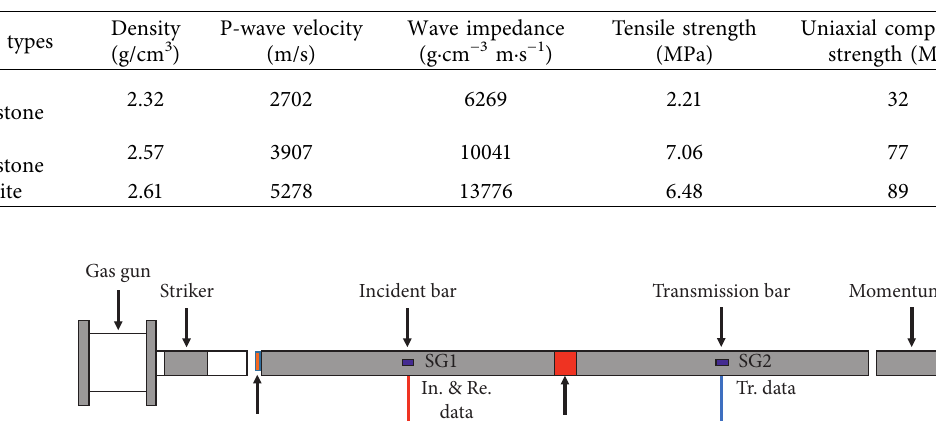
Table 1: Basic mechanical parameters of rocks.